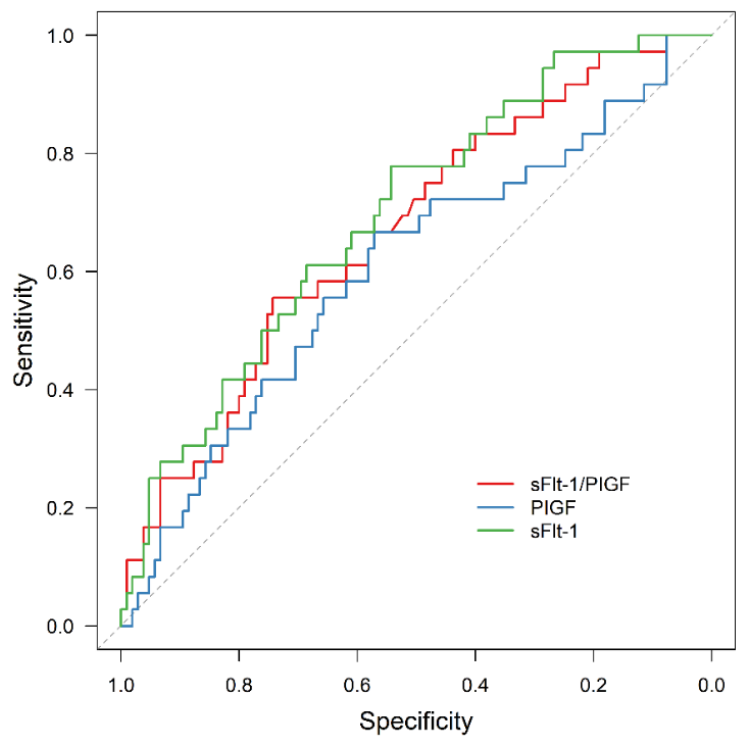
Figure 8. ROC curve for AMO prediction by sFlt-1 (AUC = 0.694, 95% CI: 0.598–0.790, p = 0.001), PIGF (AUC = 0.605, 95% CI: 0.495–0.715, p = 0.061) and sFlt-1/PIGF (AUC = 0.667, 95% CI: 0.566–0.768, p = 0.003). ROC receiver operating characteristic, APO adverse perinatal outcome, sFlt-1 soluble